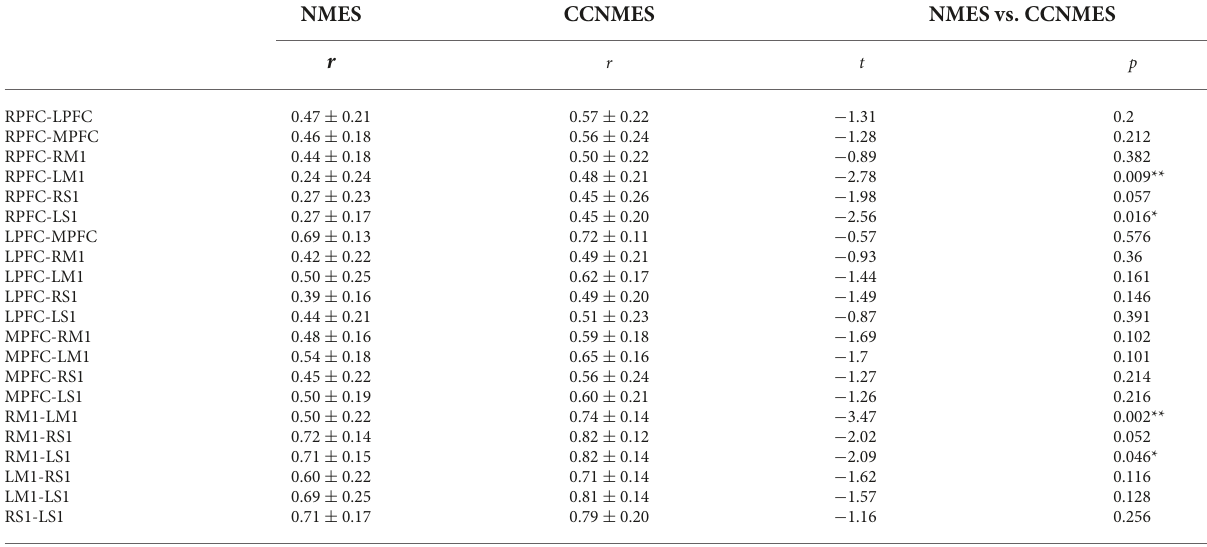
TABLE 2 The Pearson correlation coefficients between each ROI pairs in two